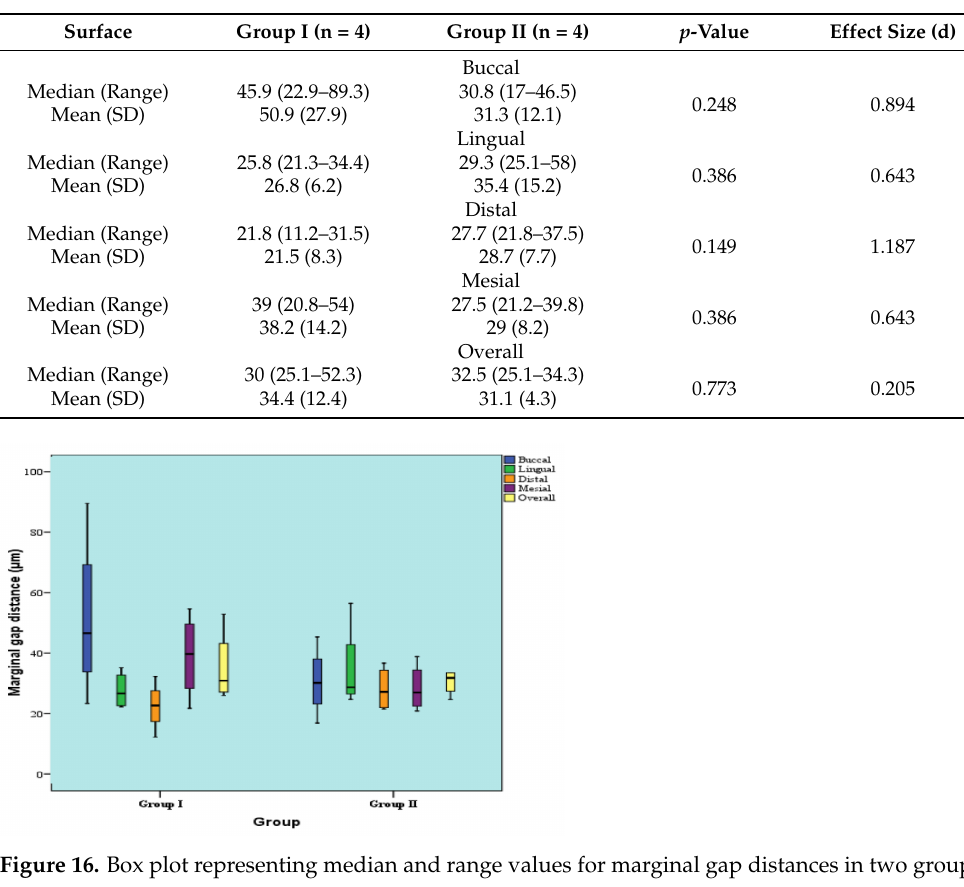
Table 3. Descriptive statistics and results of Mann–Whitney U test for comparison between marginal gap distances ( µ m) in the two groups (mesial retainer).